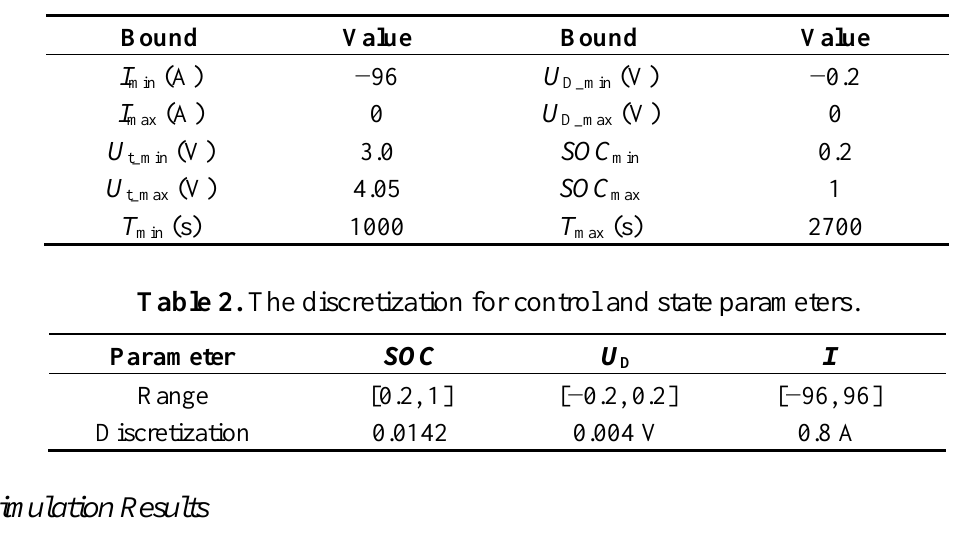
Table 1. The comparison of different methods.